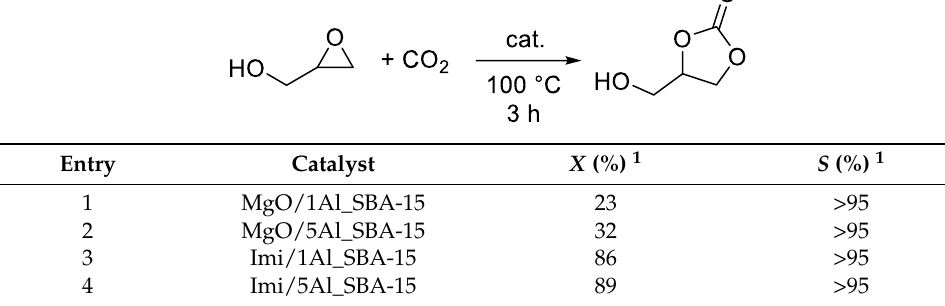
( b ) Figure 6. Pressure profile during the glycidol conversion to the corresponding cyclic carbonate for Imi/1Al_SBA-15 ( a ) and Imi/5Al_SBA-15 ( b ). They, respectively, refer to Entries 3 and 4 in Table